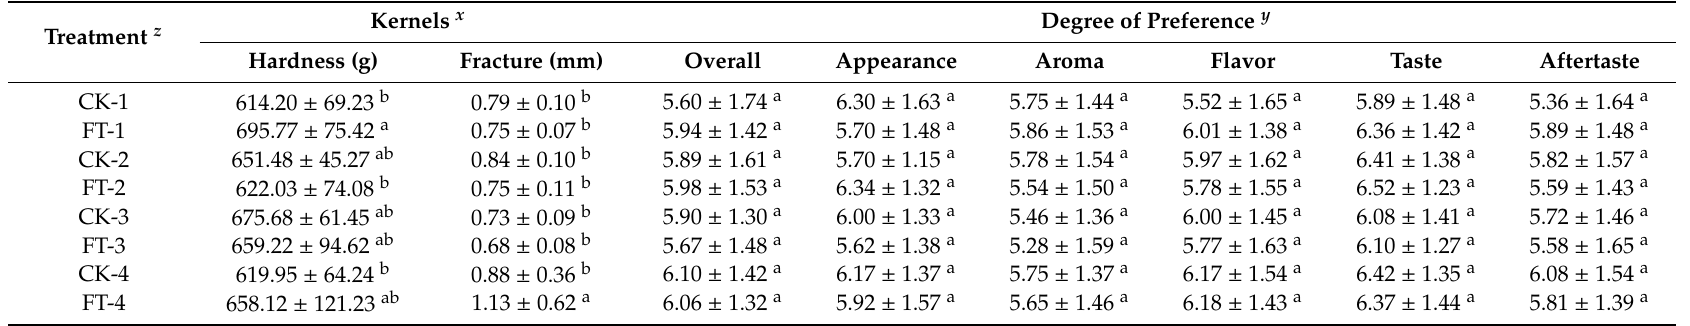
Table 4. The hardness, brittleness, and consumer acceptance evaluation of flooding treated vegetable soybeans ‘Kaohsiung 9’.